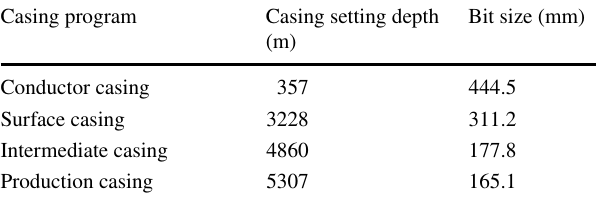
Fig. 1 Effect of glycol concentration on CPT Table 1 Drilling program for Boshen-8